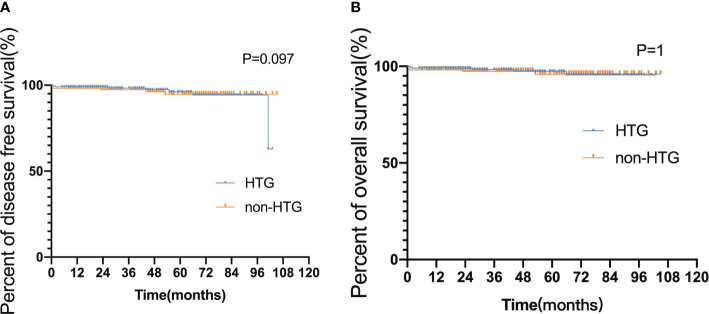
Disease-free survival and overall survival in HTG and non-HTG patients with APL. (A) Disease-free survival and (B) overall survival HTG group, high triglyceride group ≥ 1.70 (mmol/L); non-HTG group, triglyceride < 1.7 (mmol/L); Significant difference (P < 0.05).